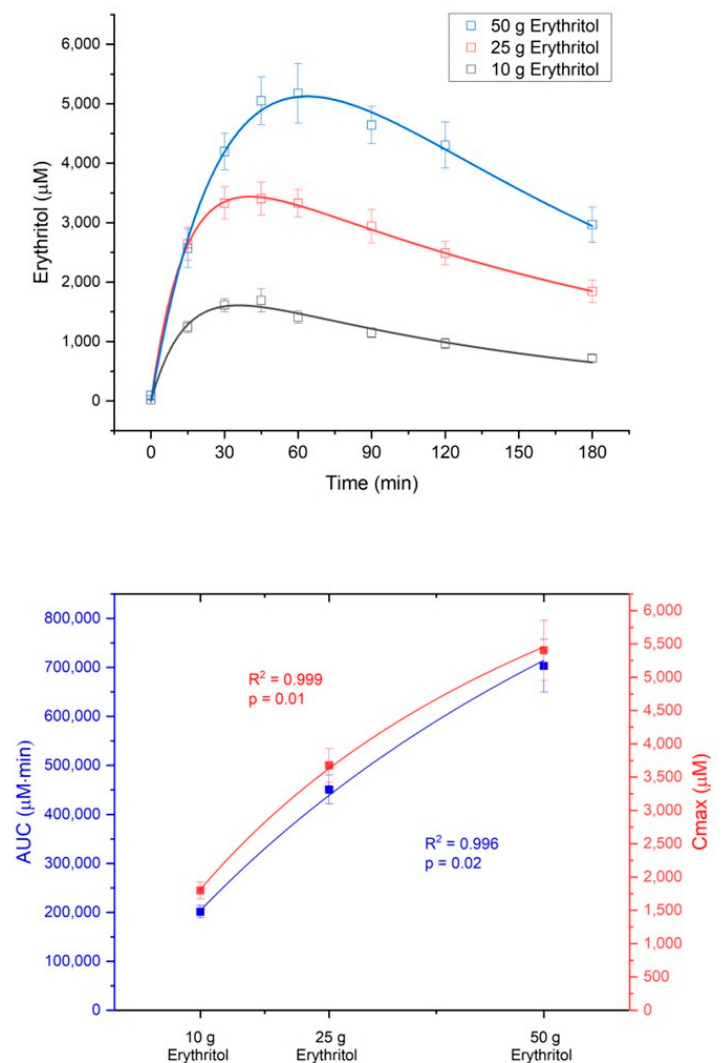
Figure 2. Dose-dependent absorption of erythritol. Upper part: concentration–time curves after administration of the three loads; lower part: dose-response for the area under the curve from 0 to 180 min (AUC180) and the maximum deviations from baseline (Cmax). Data are expressed as mean ± SEM. Data were best fit with a non-linear dose-response model.